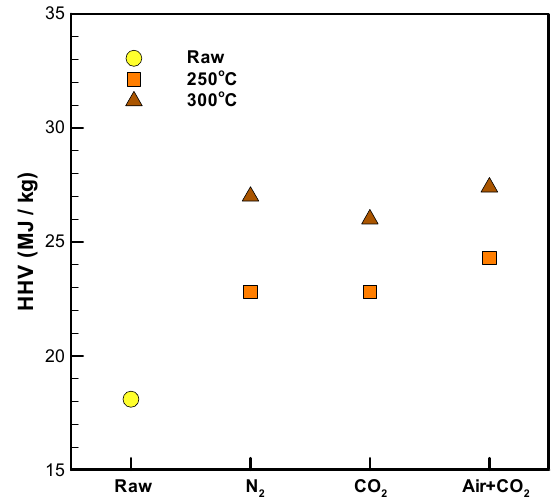
Figure 6. Profiles of HHV of raw and torrefied corncob waste.